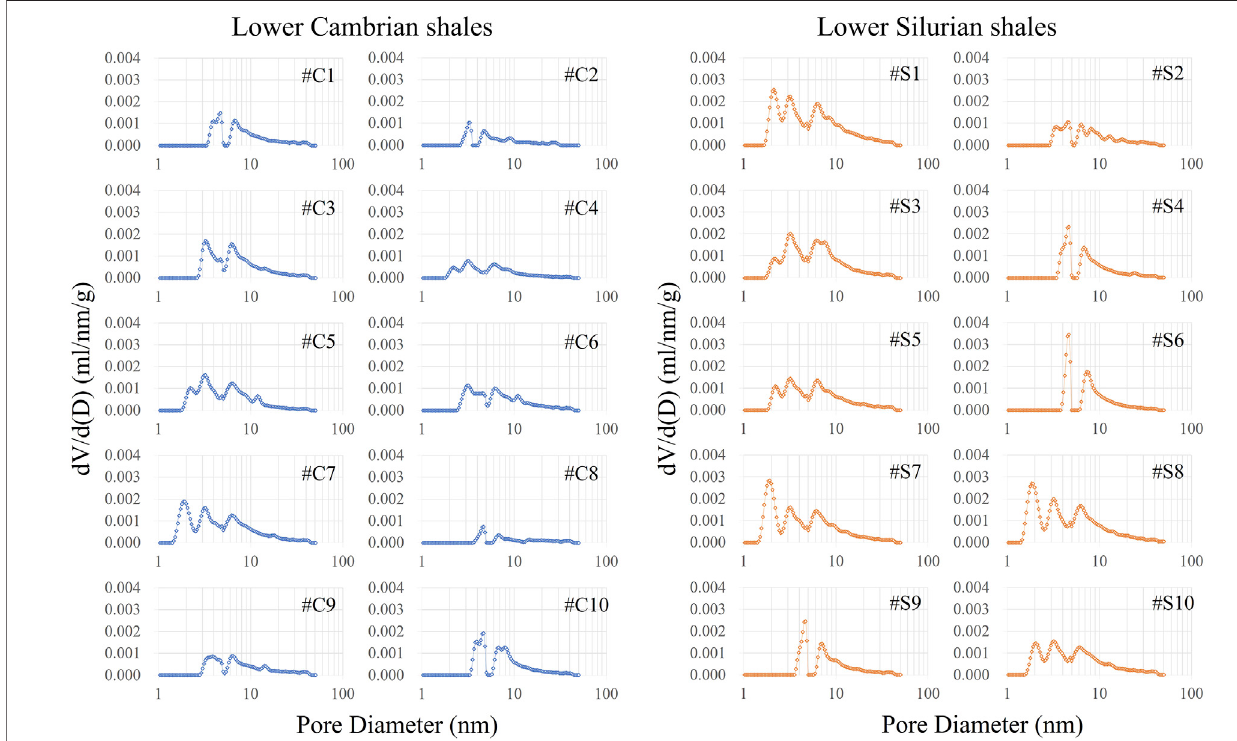
FIGURE 4 | Relationships between pore volumes and pore diameters of the Lower Cambrian shales and Lower Silurian shales.